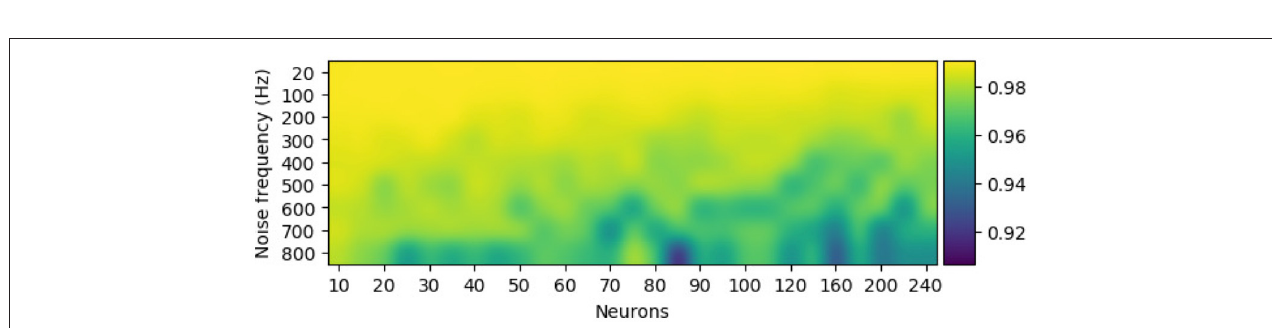
FIGURE 6 | The configuration of the perturbation layer, i.e., the number of neurons and their firing rate, modulates the similarity of the synthetically generated sample to its template for the C4 electroencephalography (EEG) signal. Pearson’s correlation between the averaged synthetic samples (100 samples) and the template showcase higher deviation from the template with more neurons and a high firing rate in the perturbation layer.